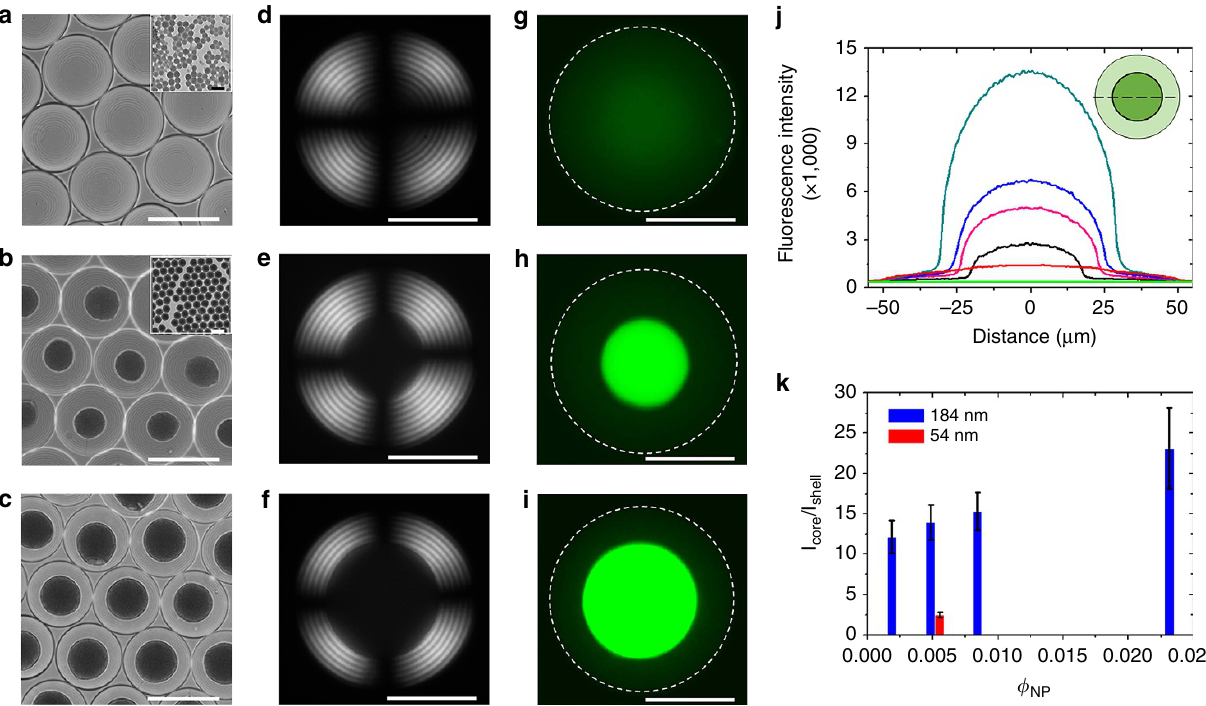
Figure 5 | Loading of Ch-CNC droplets with latex NPs. BF ( a – c ), POM ( d – f ) and FM ( g – i ) images of droplets containing fluorescein isothiocyanate dye- labelled 54nm latex NPs at f NP ¼ 0.0052 ( a , d , g ) and 184nm dye-labelled latex NPs at f NP of 0.0052 ( b , e , h ) and 0.0235 ( c , f , i ). The scale bars in a – c are 100 m m; the scale bars in d – i are 50 m m. Insets in a , b show the corresponding TEM images of 54 and 184nm latex NPs. The scale bar in insets is 100nm in a and 300nm in b . ( j ) Representative fluorescence line profiles of the Ch-CNC droplets loaded with 54nm latex NPs at f NP ¼ 0.0052 (red) and 184nm NPs at f NP of 0 (green), 0.0022 (black), 0.0052 (magenta), 0.0088 (blue) and 0.0235 (dark cyan). Inset shows the schematic of a droplet with a fluorescence line profile drawn through the droplet centre (dashed line). To prepare droplets with f NP ¼ 0, the Ch-CNC phase was mixed with a supernatant of the latex dispersion. ( k ) Variation in the core-to-shell fluorescence intensity ratio plotted as a function of NP volume fraction in the